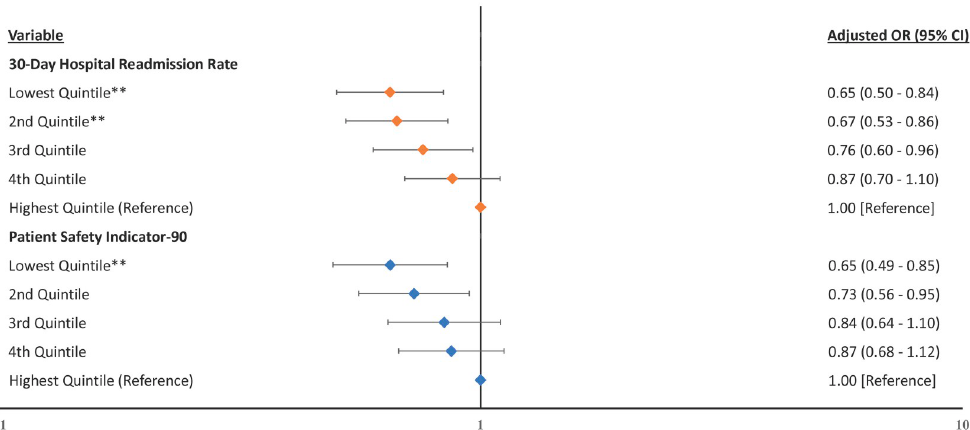
Fig 4. Forest plot of the odds ratios for the association between previous year’s measured quality and financial distress. Hospitals within the lowest previous year’s 30-day hospital-wide readmission rate quintile and hospitals within the lowest previous year’s PSI-90 score quintile experienced lower odds of financial distress compared to their respective highest quality quintiles. Notes : Forest plot showing the adjusted odds ratios with financial distress as the dependent variable with quality indicators as independent variables and adjusted for the hospital characteristics. Higher rates and scores represent worse quality. �� p �